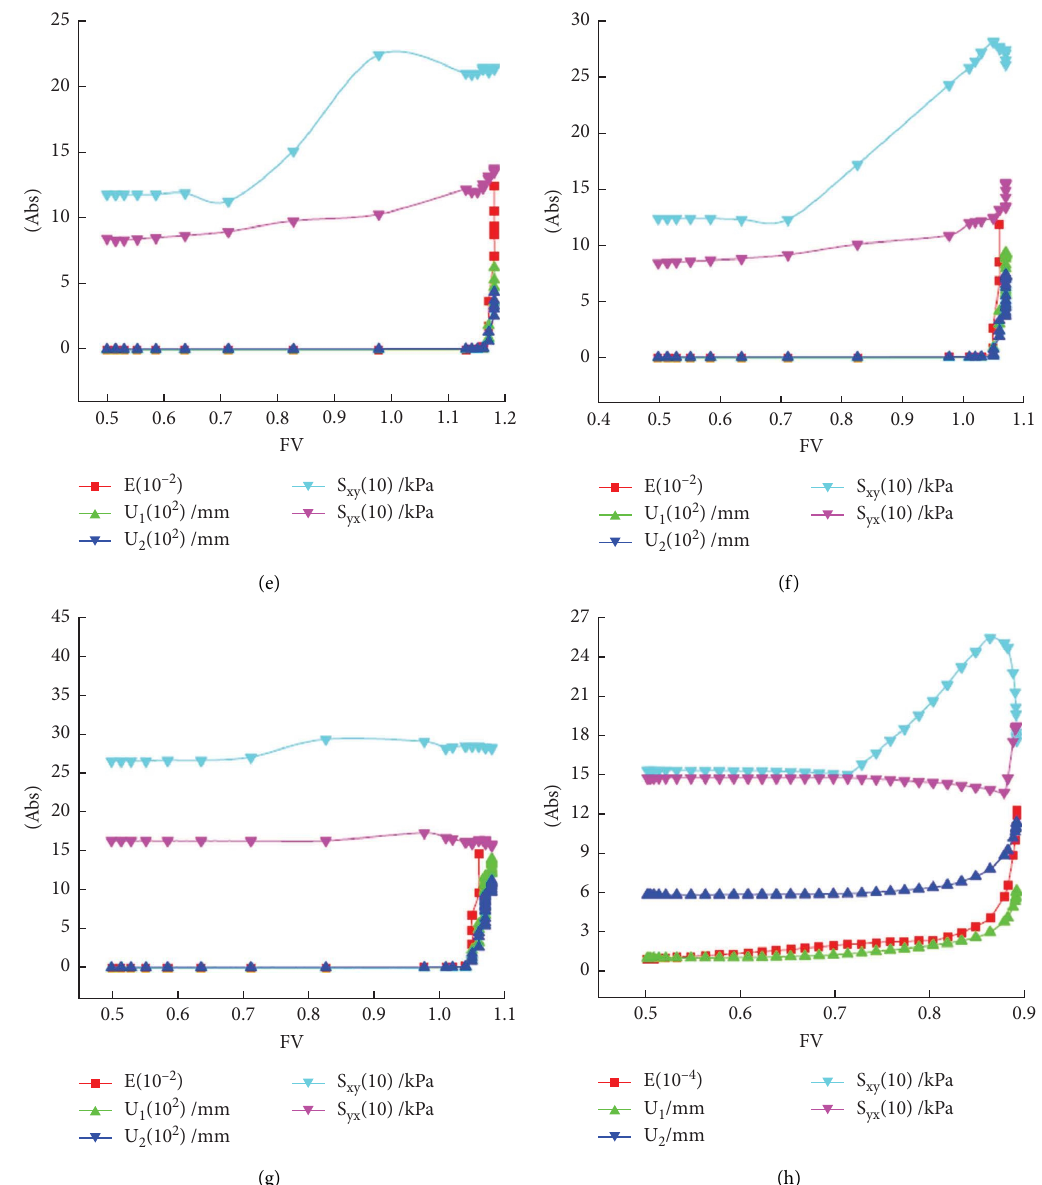
Figure 9: Mechanical response curve of slope during strength reduction: (a) before excavation, (b) seventh stage excavation, (c) sixth stage excavation, (d) ffth stage excavation, (e) fourth stage excavation, (f) third stage excavation, (g) second stage excavation, and (h) frst stage excavation.